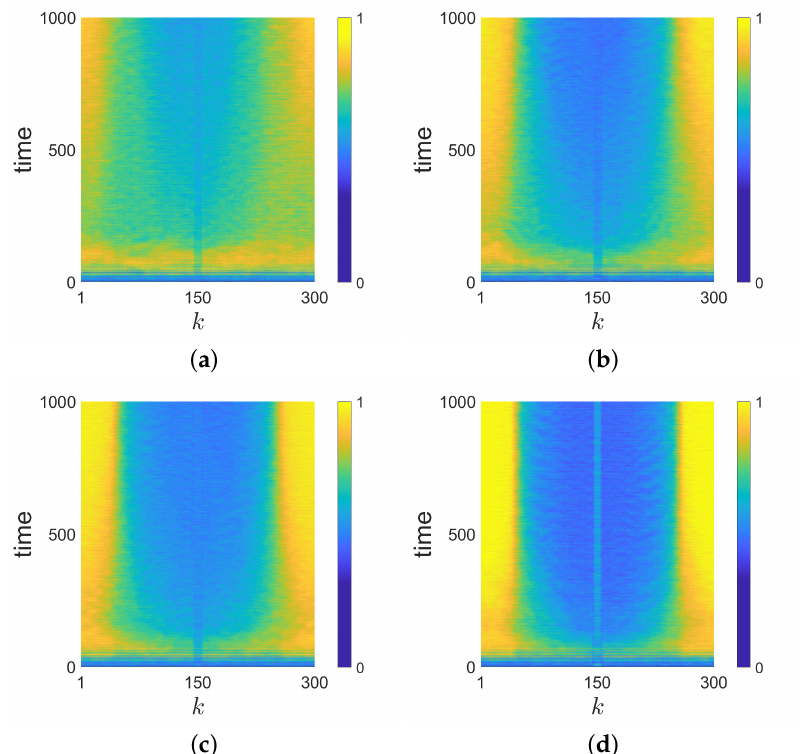
Figure 3. The number of pruned neurons affects the performance of the system. ( a ) Average local order parameter of 50 cases when N p = 1 (node 150), ( b ) N p = 2 (nodes 150 to 151), ( c ) N p = 3 (nodes 149 to 151), ( d ) N p = 5 (nodes 148 to 152). N = 300, other parameters are the same as in Figure